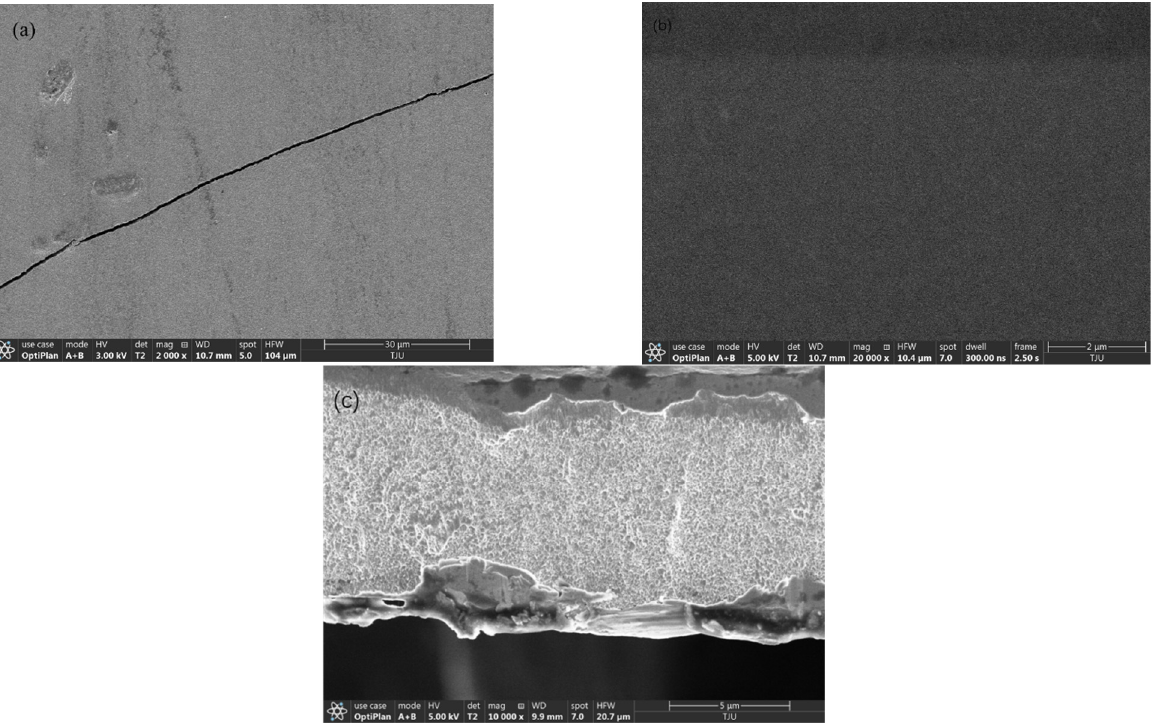
Figure 14. SEM photos of surface and section of Fe-Co films electrodeposited by (NH 4 ) 2 SO 4 . ( a ) Surface morphology without (NH 4 ) 2 SO 4 . ( b ) Surface morphology with (NH 4 ) 2 SO 4 . ( c ) Section morphology with (NH 4 ) 2 SO 4